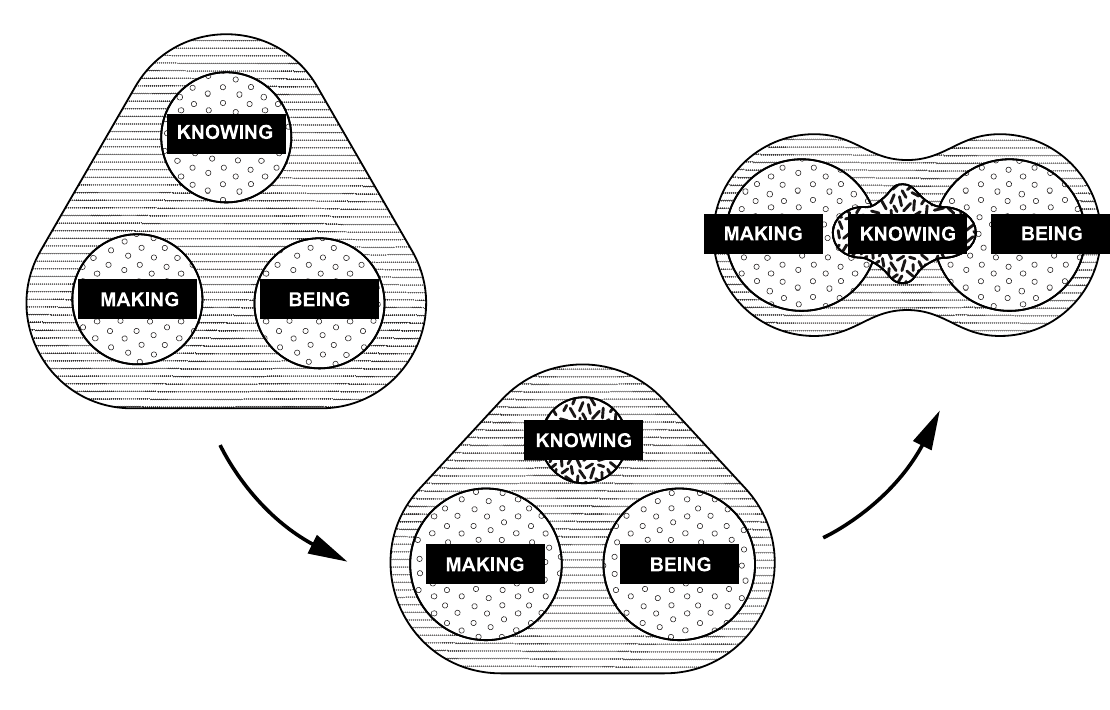
how knowledge, making and being has transformed within the current educational model. (upper right hand side of the